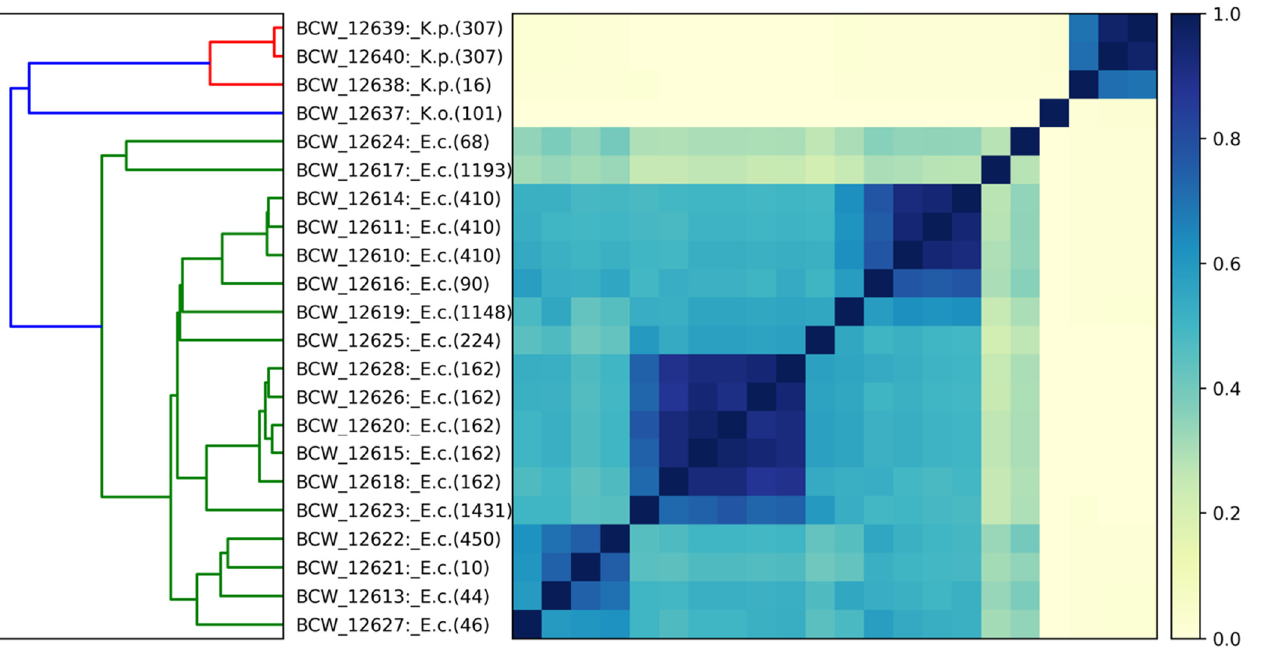
Figure 3. Sample genome assembly comparisons (DNA sequence k-mer (31 bp) matching) are shown in all against all matrix by Jaccard similarity index (color scale on right: 1.0 (dark blue) is near identical, 0.0 is no observed relationship). A hierarchical clustering dendrogram (left) shows structure of relatedness (branch lengths represent relative distance between clusters, colors correspond to species). Samples are labeled by Sequence Read Archive (SRA) ID number, species (E.c.: Escherichia coli , K.p.: Klebsiella pneumoniae , K.o.: Klebsiella oxytoca ), and PubMLST schemes ( Esche- richia coli [Achtman], Klebsiella pneumoniae species complex [Pasteur], and Klebsiella oxytoca ), respec- tively. The plot shows clustering corresponding to species and MLST.